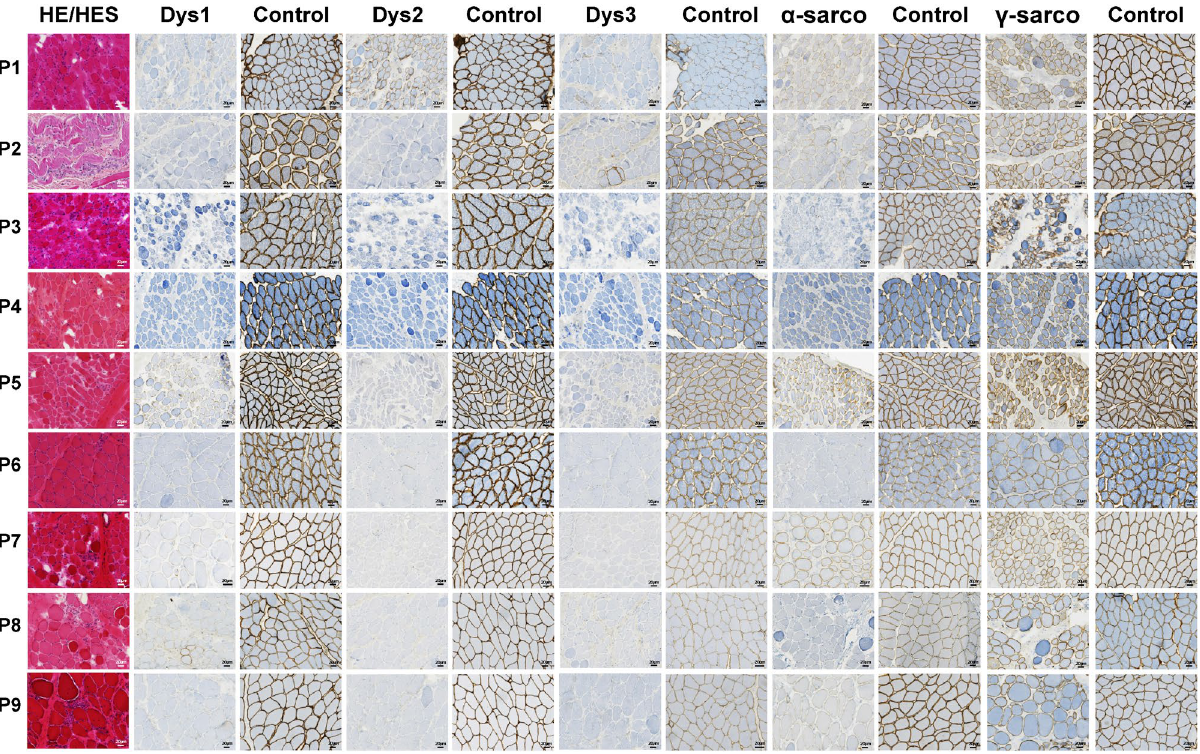
Figure 1. Morphological and immunohistochemical characteristics of DMD patients’ muscles. Left column: Haematoxylin–Eosin (HE) (P1, P3, P4, P5, P6, P7, P8, P9) or Hemalun-Eosin-Safran (HES) (P2) displaying endo-and perimysial fibrosis, necrotic and atrophic fibres along with inflammatory infiltrates suggestive of progressive musclar dystrophy. Second to seventh columns : dystrophin immunolabeling (dys 1, dys 2 and dys 3 labeling the core, NH2-terminal and COOH-terminal domains of the protein respectively) showing severely decreased or absent immunoreactivity in patients compared to control muscle apposed on the same slide. Eighth to eleventh columns : α- and γ-sarcoglycan immunolabelings showing either a decrease or normal immunoreactivity in patients compared to muscle control opposed on the same slide. Horizontal lines correspond to patients 1–9; scale bars: 20